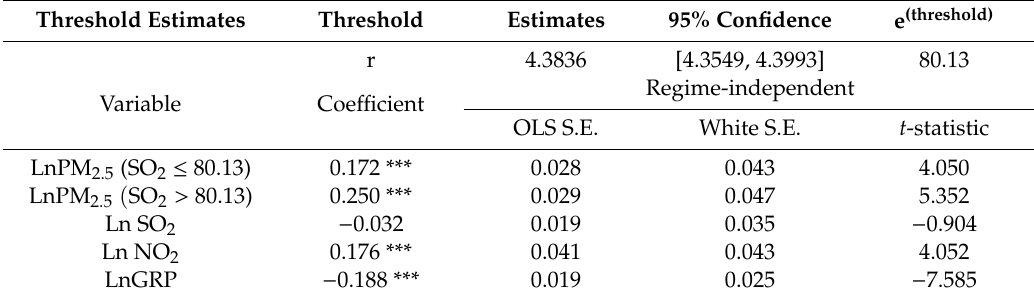
Table 6. Estimation results of PM 2.5 e ff ects on respiratory